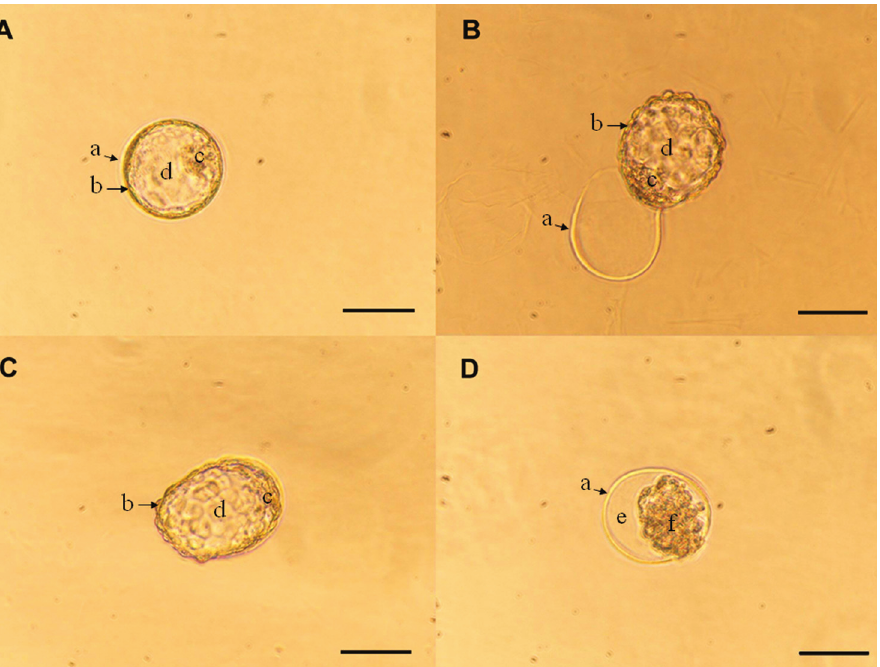
Figure 1. Murine blastocyst development. A , Blastocyst : embryos with an intact zona pellucida (ZP; a), a flat trophoectoderm (b), a protuberant inner cell mass (c), and an expanded blastocele (d). B , Hatched blastocyst : embryos that protruded partially or completely from the ZP. C , Expanded blastocyst : hatched blastocysts with an increase in diameter compared to the blastocyst or hatched blastocyst stages. D , Degenerated blastocyst : either unexpanded embryos with a space (e) between the trophoectoderm and the ZP, or embryos with cell fragmentation (f). Magnification: 10X. Scale bars = 10